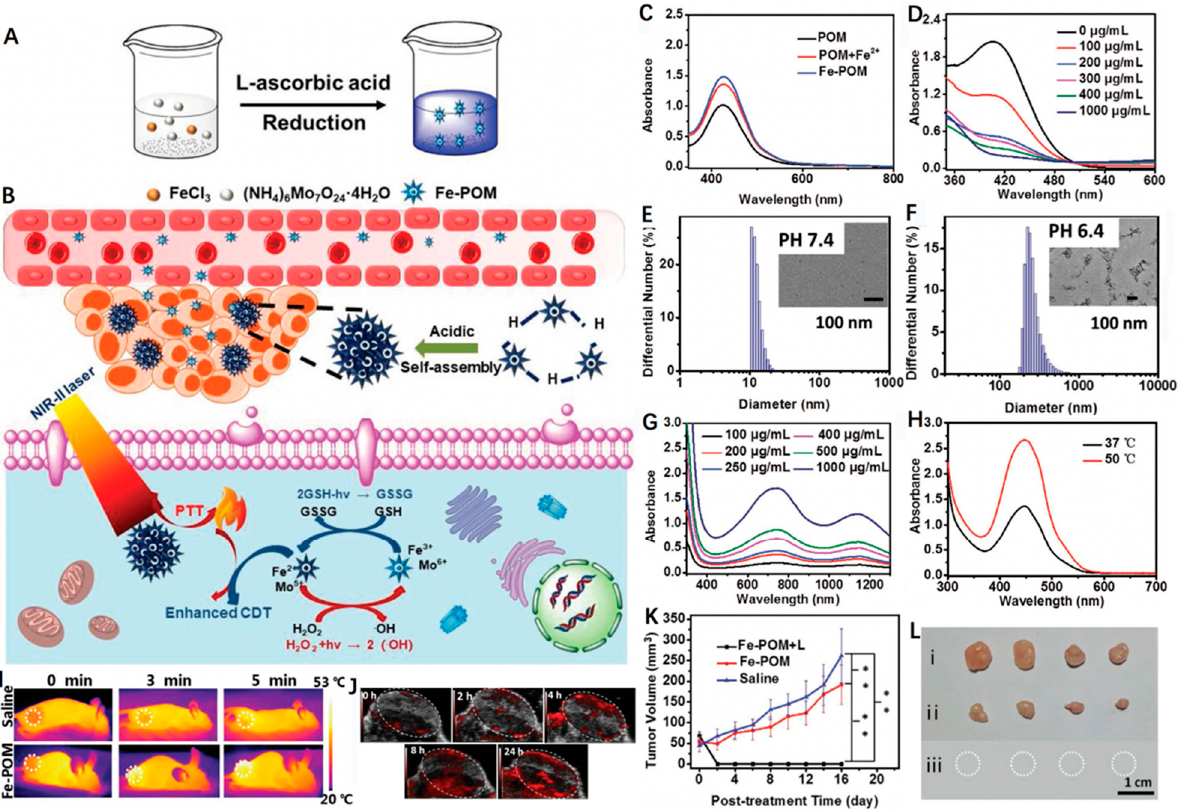
Figure 7. ( A ) A schematic illustrating the fabrication of acid-aggregated Fe-POM cluster. ( B ) Scheme showing Fe-POM for PTT-enhanced CDT in the NIR-II window. ( C ) UV-vis absorption spectra of o-phenylenediamine (OPD) changes by POM, POM + Fe 2+ and Fe-POM. ( D ) GSH depletion under the reduction of different concentrations of Fe-POM (100, 200, 300, 400, 1000 µg mL − 1 ). DLS curves and TEM images of Fe-POM clusters at ( E ) pH 7.4 and ( F ) pH 6.4. ( G ) UV-vis spectra of Fe-POM dispersions at various concentrations. ( H ) UV-vis absorption spectra of OPD incubated with Fe-POM with or without laser irradiation. ( I ) Thermal images of mice injected with saline or Fe-POM (1060 nm laser, 1 W cm − 2 ), tumor site with dot line circled. ( J ) In vivo PA images of tumor-bearing mice. ( K ) Tumor volumes in mice received three different groups. n = 4, mean ± SD. (**) < 0.01. ( L ) Representative photos of tumors after therapy (after 16 days of treatment). Reprinted with permission from Ref. [76]. Copyright 2020, Wiley-VCH Verlag GmbH & Co. KGaA, Weinheim.